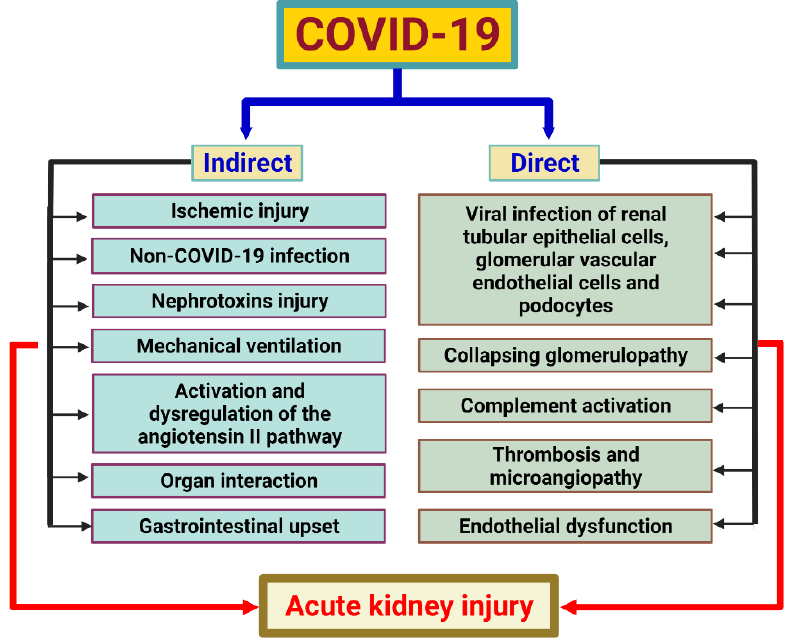
Figure 3. The putative pathogenesis of acute kidney injury (AKI) caused by COVID-19. The patho- esis of AKI in patients with COVID-19 is multifactorial, which is consistent with the pathophysiology of AKI in other critically ill patients including the direct effects of SARS-CoV-2 on kidney cells and indirect effects due to the presence of systemic mechanisms. SARS-CoV-2 may exhibit viral tropism and directly affect the kidneys. Endothelial dysfunction, coagulation dysfunction, and complement activation may be important mechanisms for the development of AKI in some patients with COVID- 19. The roles of systemic inflammation and immune dysfunction in the development of AKI in COVID-19 remain